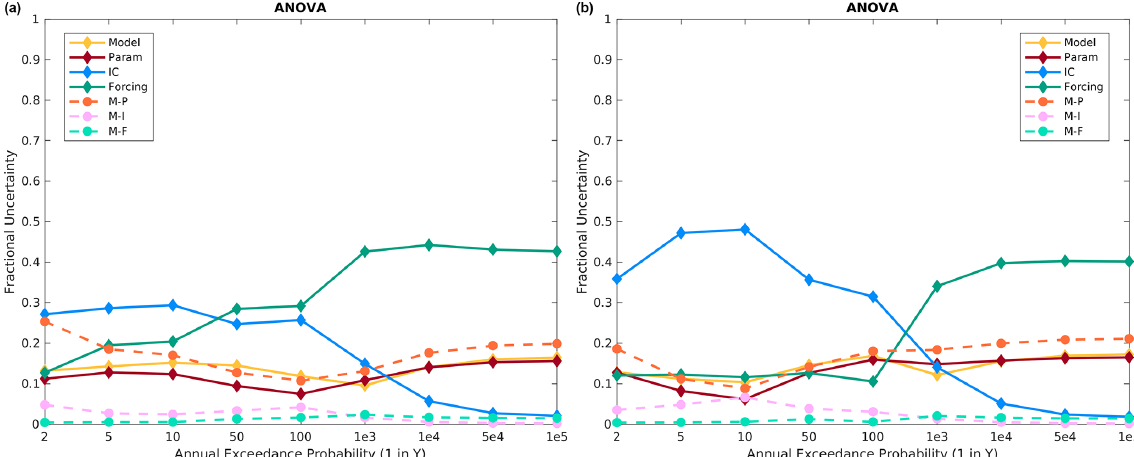
Figure 11. Altus fractional variance contributions using all 10 model structures for the (a) specified meteorological sequence and (b) histor- ical meteorological